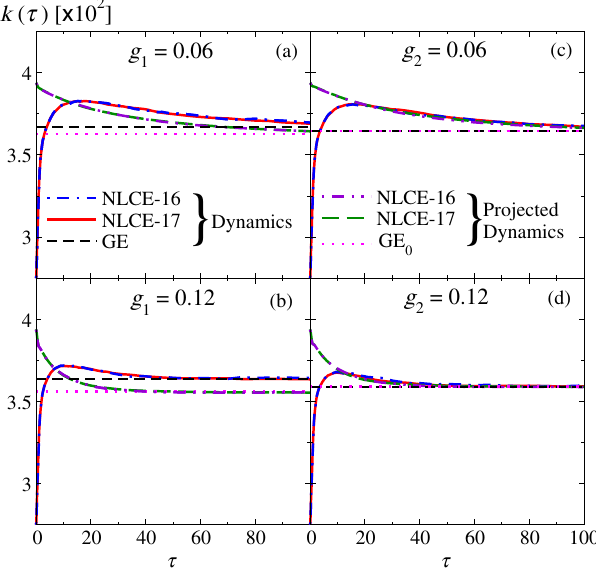
FIG. 3. Dynamics of the one-body nearest neighbor correlation k ð τ Þ for (a) g 1 ¼ 0 . 06 , (b) g 1 ¼ 0 . 12 , (c) g 2 ¼ 0 . 06 , and (d) g 2 ¼ 0 . 12 . Results are shown for the 16th (NLCE-16) and 17th (NLCE-17) orders of the NLCE, both for the dynamics [see legends in (a)] and for the dynamics in the projected basis of [see legends in (c)]. The horizontal lines show the results for the grand canonical ensemble corresponding to the original dynamics (GE) and to the projected dynamics (GE 0 ), both evaluated at the 17th order of the